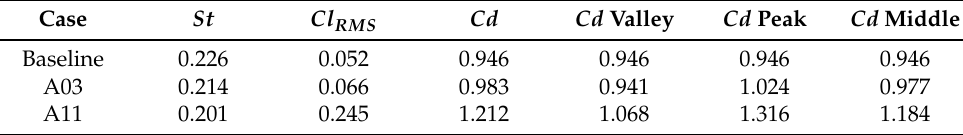
Table 5. Summary of relevant non-dimensional coefficients for the simulated